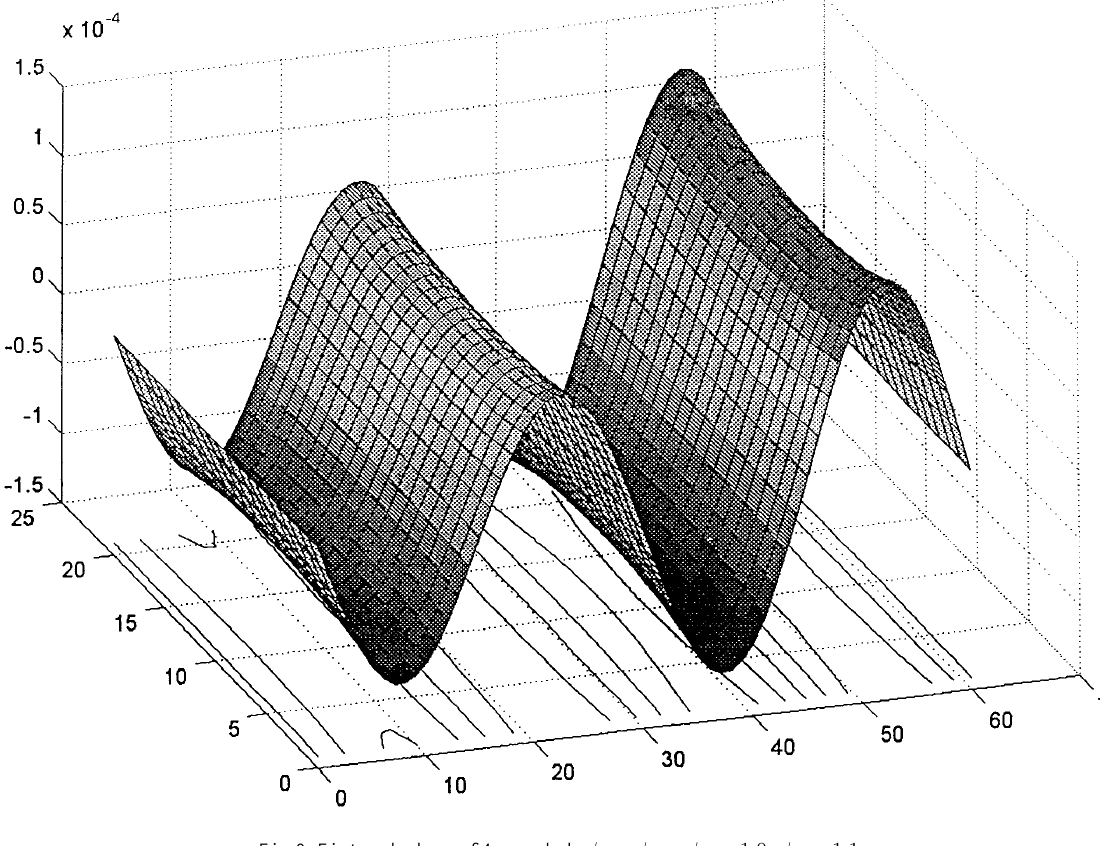
Fig. 9. First mode shape of 4-span deck, φ 1 = φ 3 = φ 4 = 1 . 0 , φ 2 = 1 . 1 .